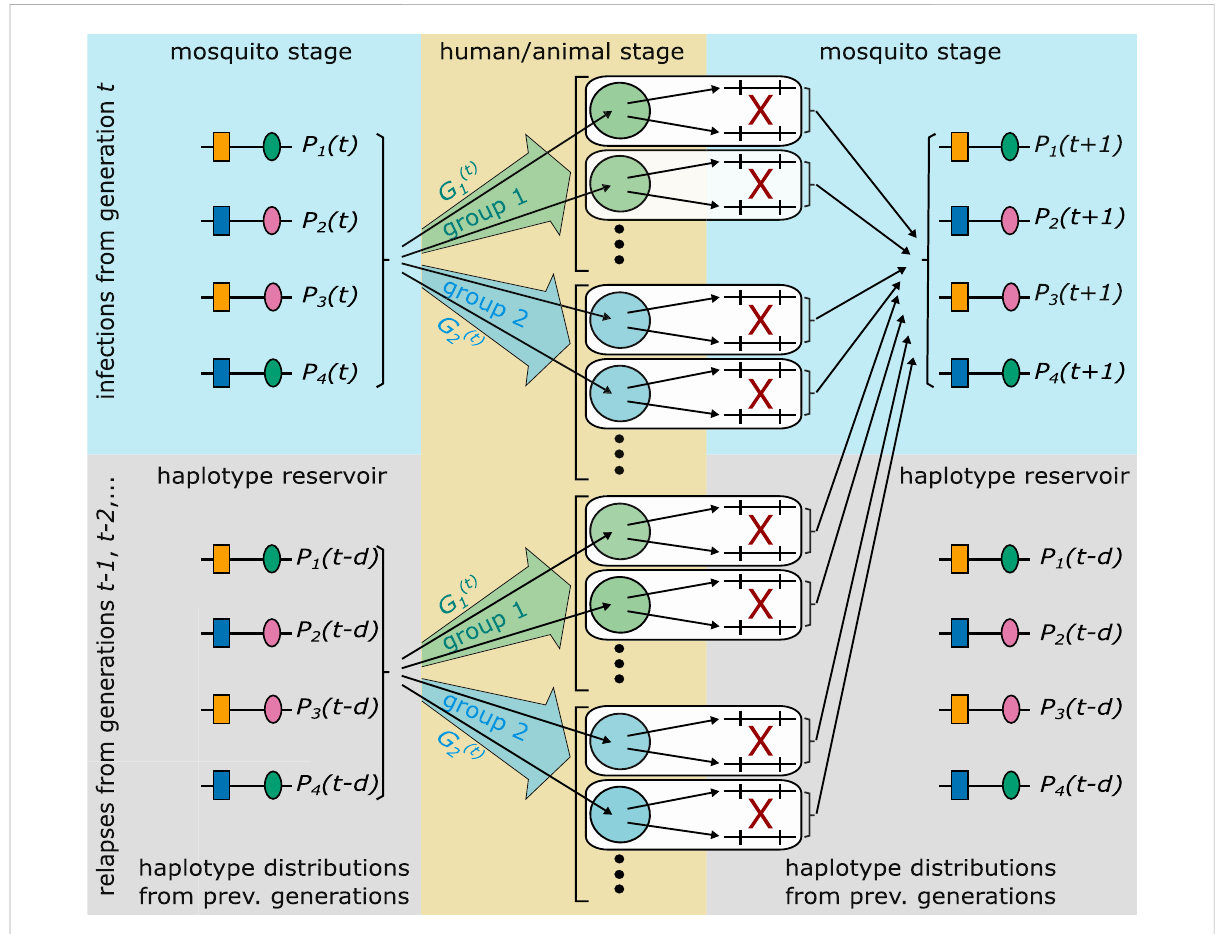
Illustrated is the idealization of the malaria transmission cycle underlying the population-genetic framework. The illustrated genetic architecture of malaria haplotypes assumes two biallelic loci, leading to four possible haplotypes. Furthermore, two groups of hosts are illustrated. Each host is infected by randomly drawing haplotypes from generation t , or a relapse/recrudescence from a previous generation occurs, which corresponds to randomly draw parasites from a previous generation (haplotype reservoir). With probability G ( t ) g a host belongs to group g in generation t . The selectiveenvironmentis different inthe twogroups. Recombination occurs exclusively betweenhaplotypes exiting thesame host. After recombination, haplotypes in the mosquitoes are pooled together to derive their distribution in generation t